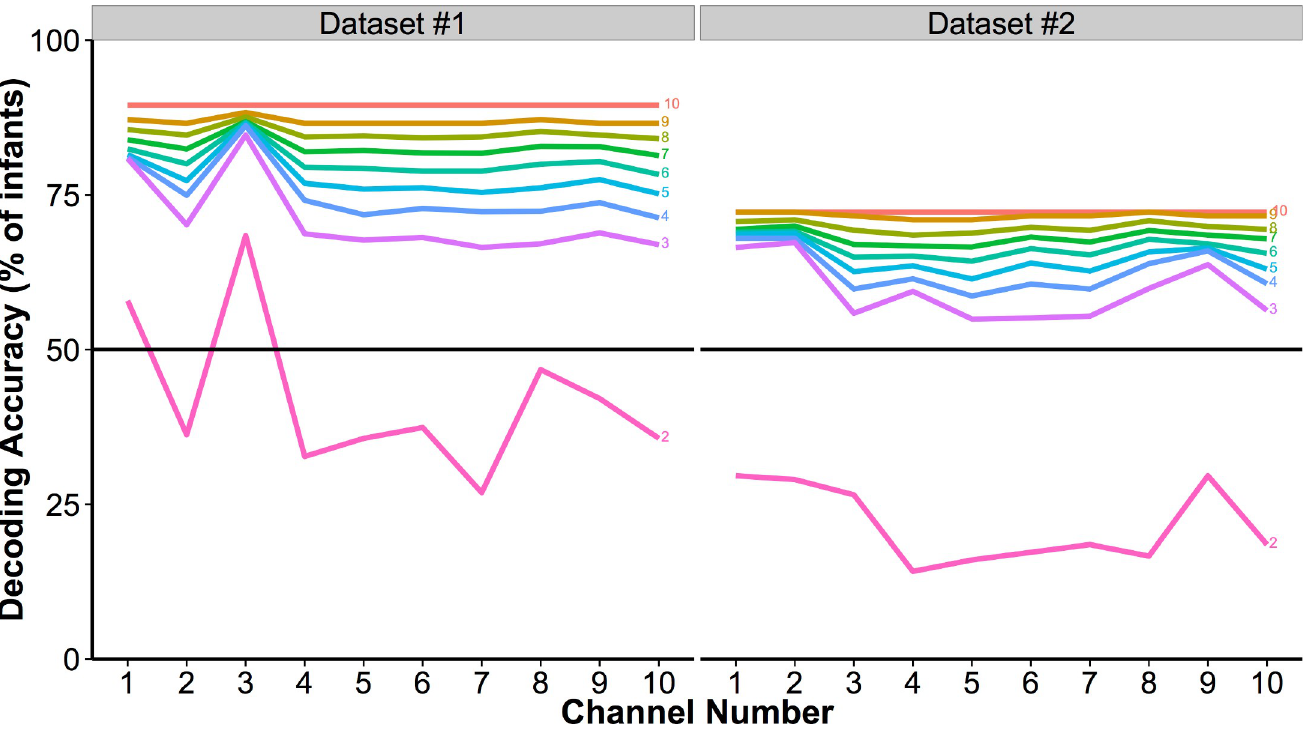
Fig 5. Accuracyfor each of the 10 NIRS channels for Dataset #1 (left) and Dataset#2 (right) in different subset sizes (from 2 to 10 channels with each line labeled at the right with the subset size).